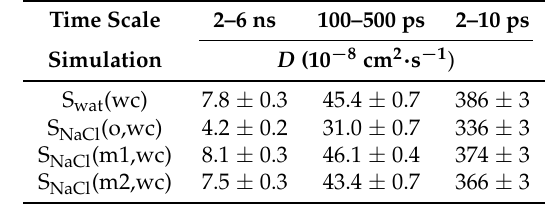
Figure 6. Deuterium order parameter − S i (Equation (11)) of the CH n groups i of the oleoyl ( a ) and palmitoyl ( b ) chains for simulations S wat (wc), S NaCl (o,wc), S NaCl (m1,wc) and S NaCl (m2,wc), shown as black, red, green and blue circles, respectively. The first (carboxylate) and last CH n groups are omitted from the analysis. The simulation acronyms are explained in Table 7. Table 6. Long- (2–6 ns), medium- (100–500 ps) and short-timescale (2–10 ps) lipid center of mass diffusion coefficients (Equation (15)) for simulations S wat (wc), S NaCl (o,wc), S NaCl (m1,wc) and S NaCl (m2,wc). The time intervals refer to the regime used for a linear fit to the mean square displacement. The simulation acronyms are explained in Table